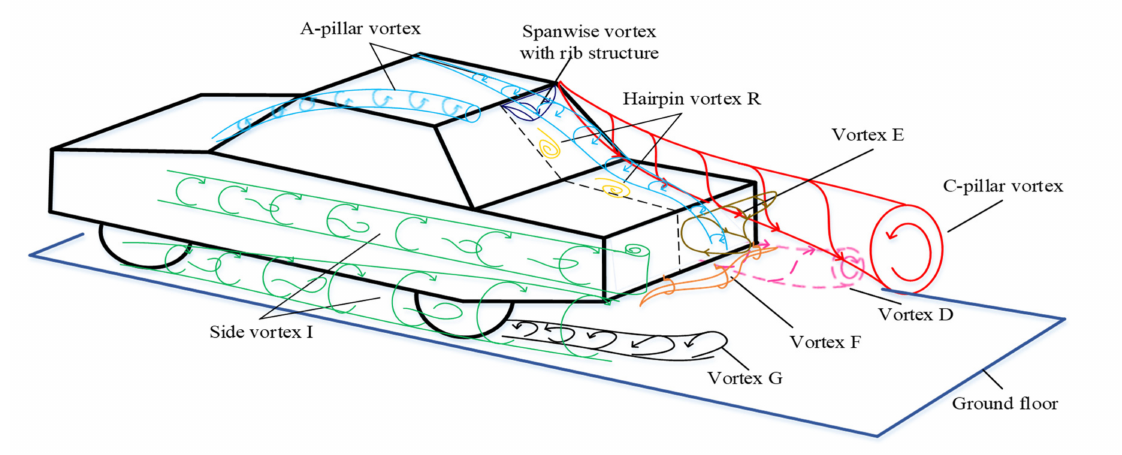
Figure 29. Flow structure schematic of MIRA notchback